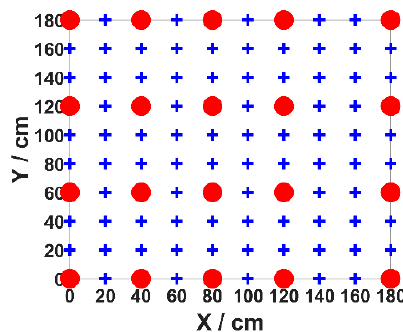
Figure 5. Even training data set.